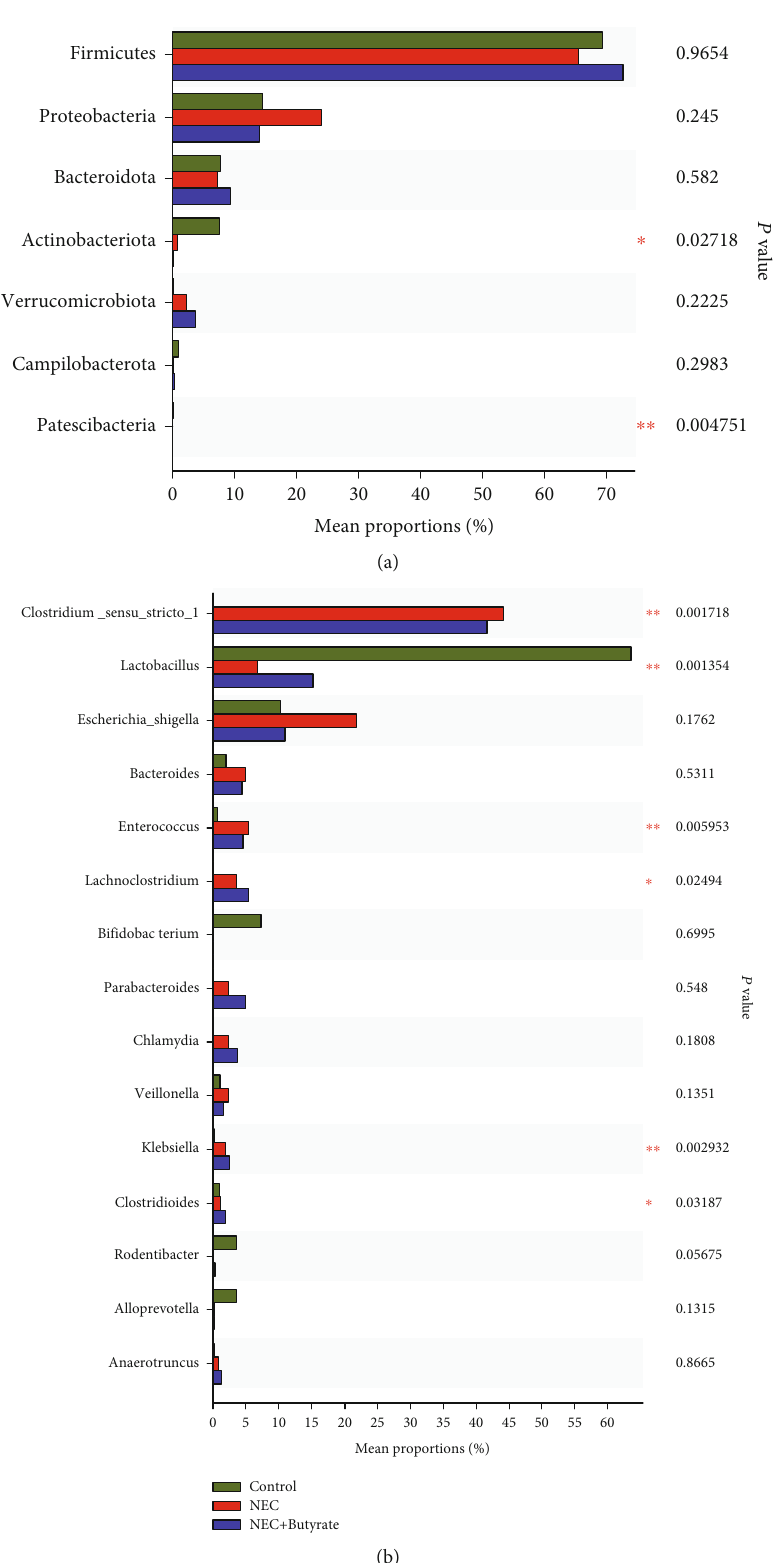
Figure 6: (a) Di ff erences in the proportions of micro fl ora constituents at the phylum level in mice in the three groups. ∗ The top seven phyla are shown in the fi gure. (b) Di ff erences in the proportions of micro fl ora constituents at the genus level in mice in the three groups. Number of samples: control ( n = 7 ), NEC ( n = 7 ), and NEC+butyrate ( n = 7 ). Statistical analysis: Kruskal-Wallis H test. ∗ 0 : 01 < P ≤ 0 : 05 ; ∗∗ 0 : 001 < P ≤ 0 : 01